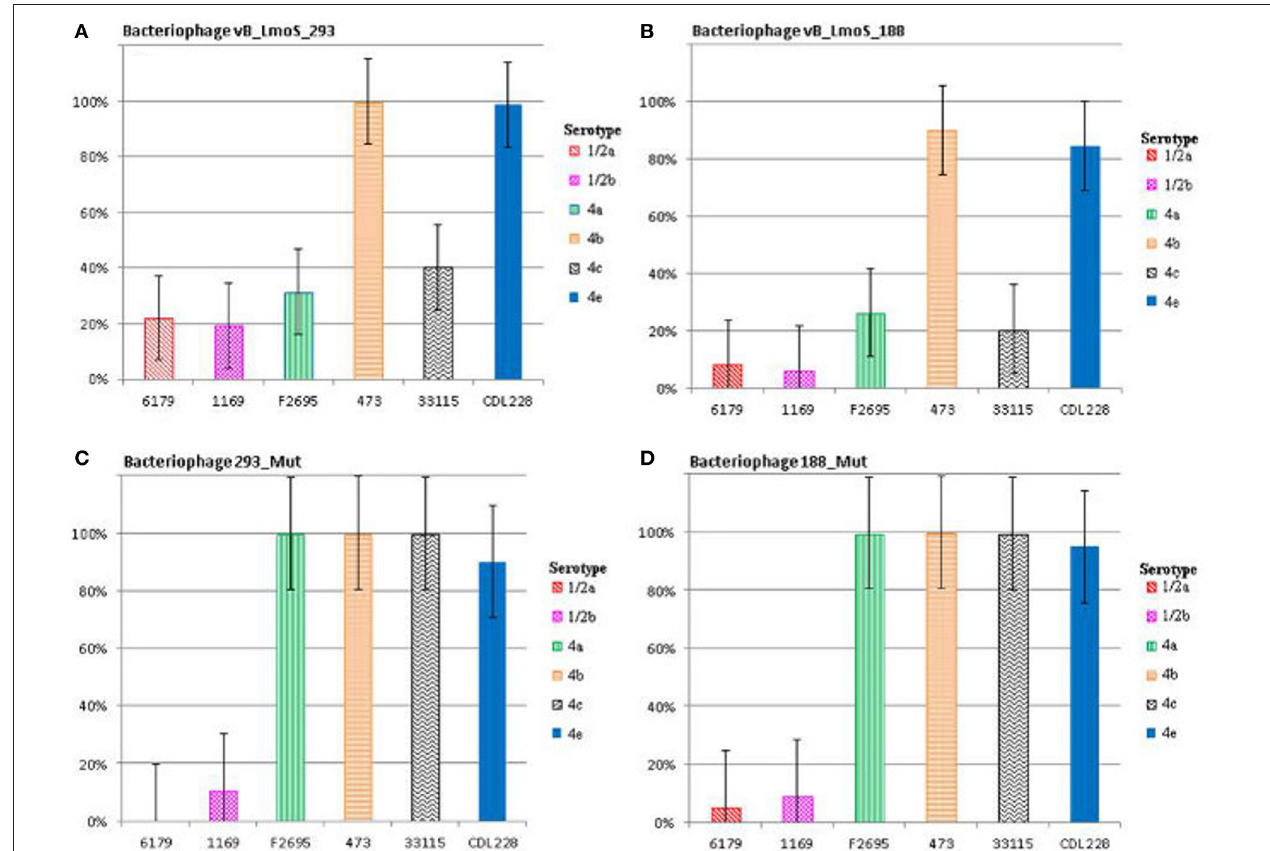
FIGURE 2 | Relative % adsorption of phages against a selection of L. monocytogenes strains of differing serotypes; vB_LmoS_293 (A), vB_LmoS_188 (B), 293_Mut (C), 188_Mut (D). The numbers are the average of triplicate tests, and represent the percentage of phage particles adsorbed to the surface of each test strain compared to the control. The error bars for each value represent the standard error of the